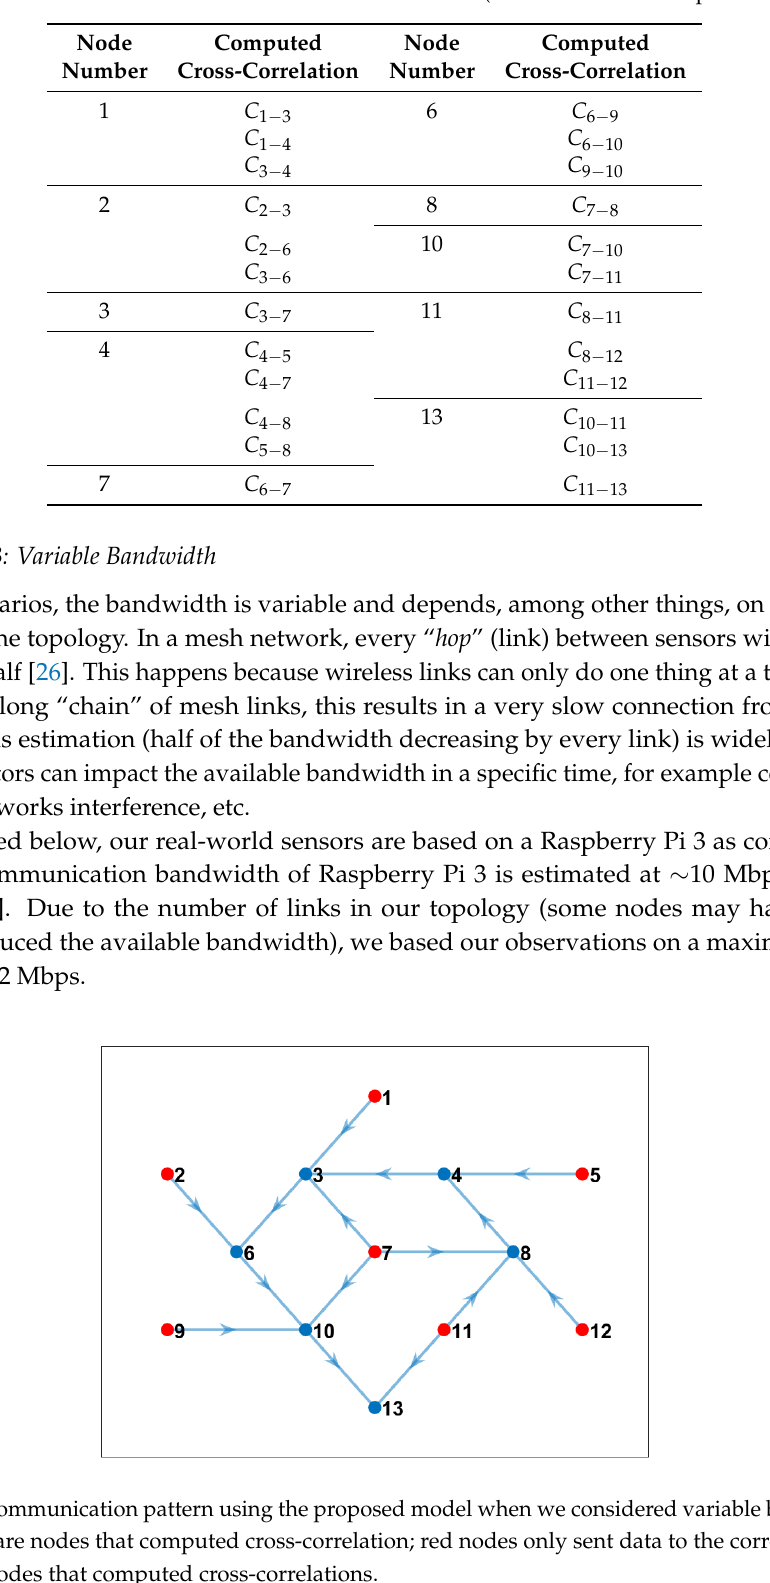
Table 5. Number of cross-correlations for each selected node (limited bandwidth up to 2 neighbors).